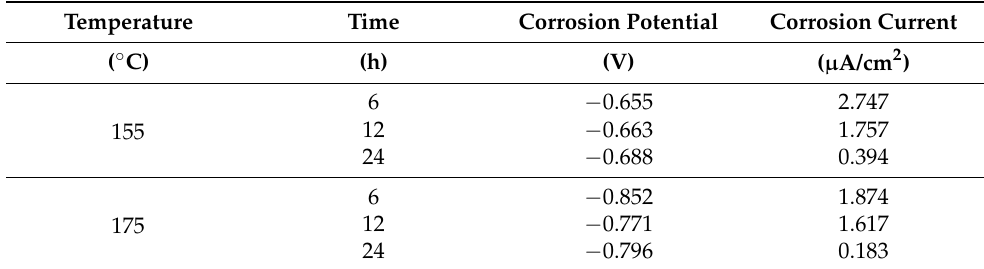
Figure 5. Polarization curves at: ( a ) T = 155 °C; ( b ) T = 175 °C.